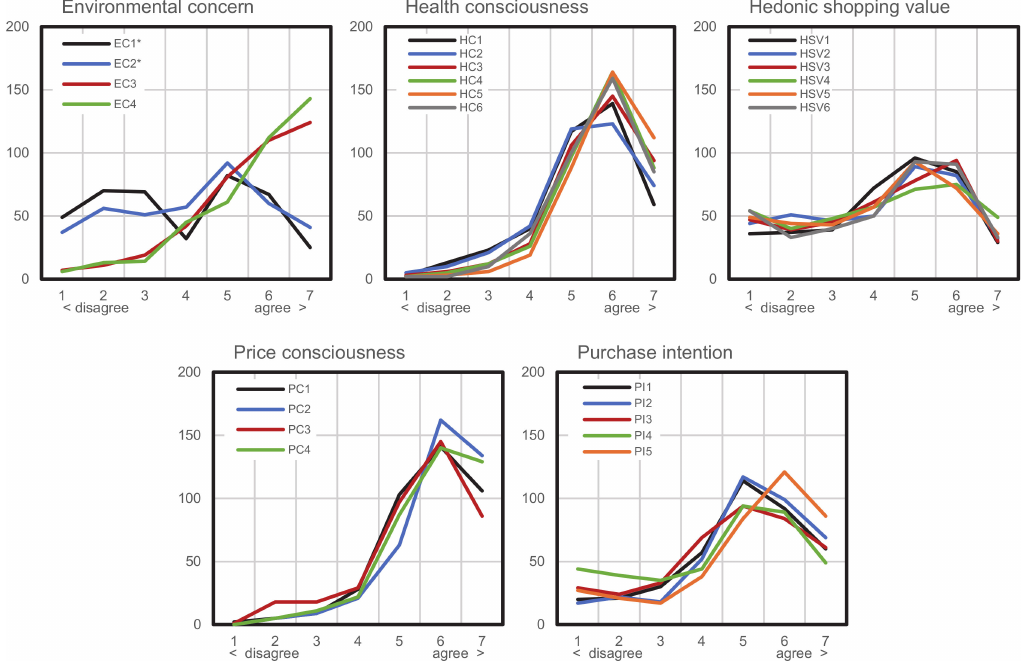
Figure 2. Overview of responses ( n = 394). Notes: y -axis: number of responses; x -axis: 7-point scale (1 =